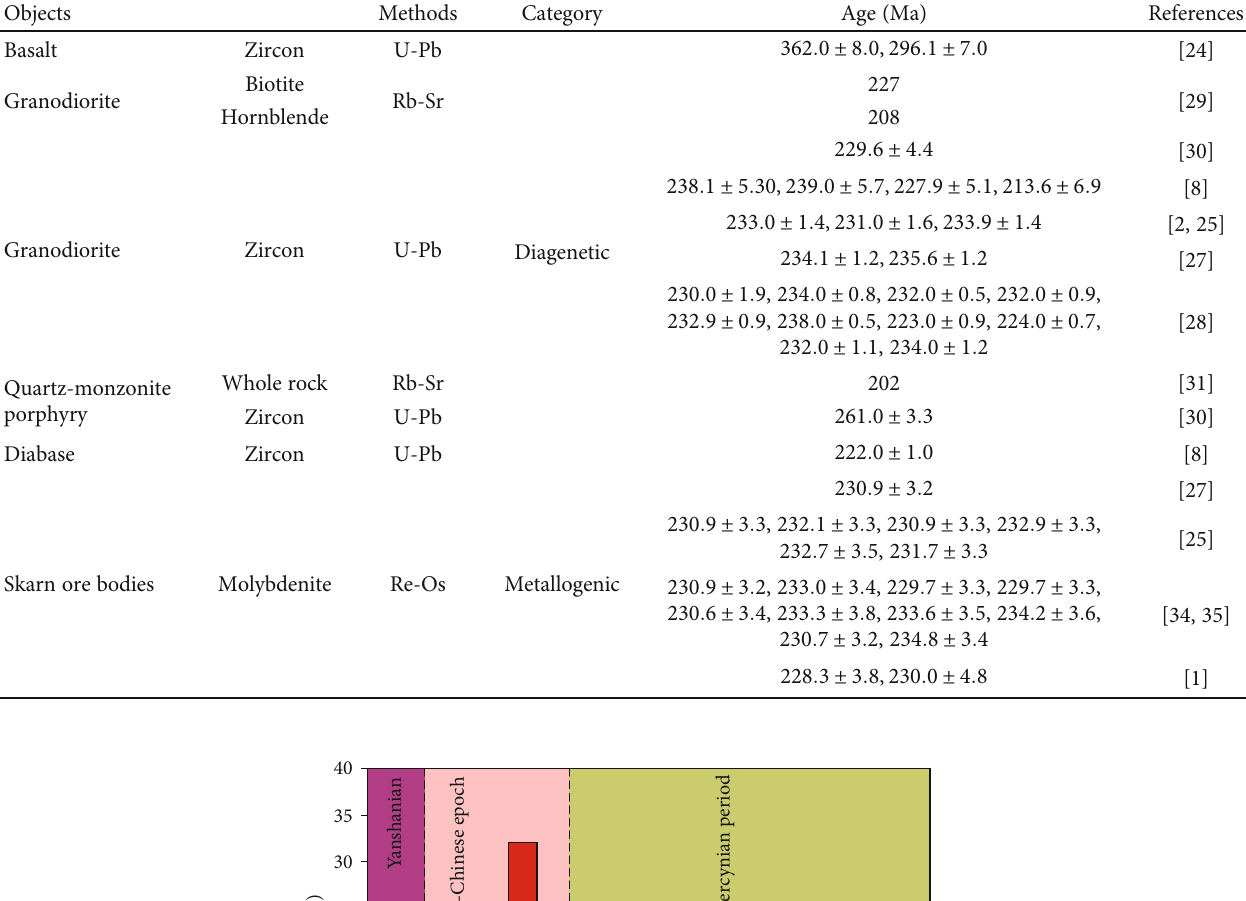
Table 1: The statistical data of the diagenetic and metallogenic ages in Yangla copper deposit, Yunnan, China. Objects